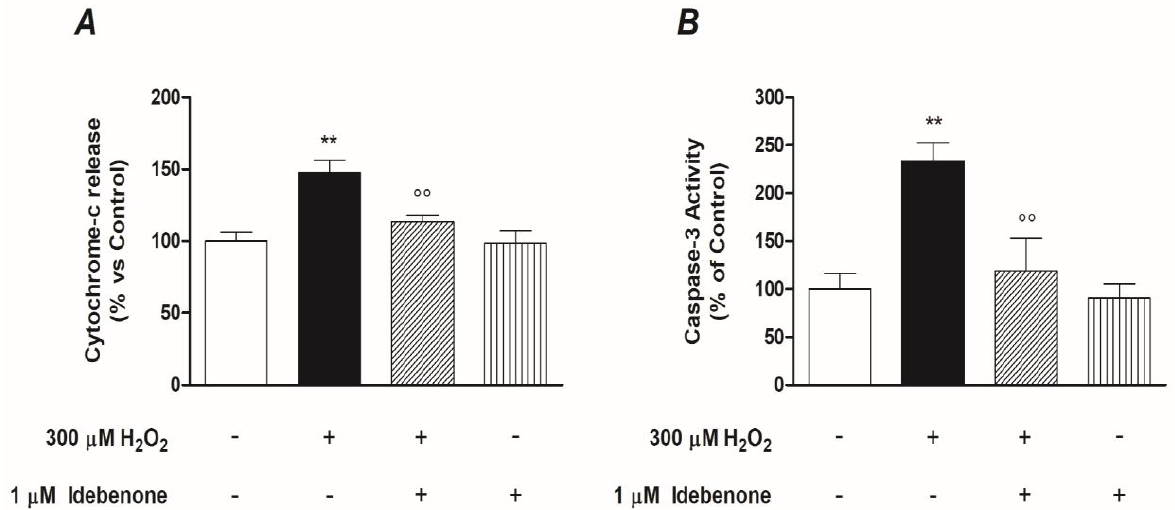
Figure 7. Idebenone inhibits cytochrome c release and Caspase-3 enzymatic activity. Effect of the idebenone pre-treatment (1 µM for 24 h) both on the release of Cytochrome-c ( A ) and the activity of Caspase-3 ( B ) in the presence or absence of 300 µM H 2 O 2 -induced oxidative stress for a further 24 h. Results are quantified by measurement of OD (see Materials and Methods) and are reported as a percentage of the ARPE-19 untreated cells (arbitrarily set to 100%). The graphs are the result of three independent experiments performed in triplicate, the means ± SEM of 9 replicates per group. ** p < 0.01 and °° p < 0.01 vs. control and H 2 O 2 alone, respectively.